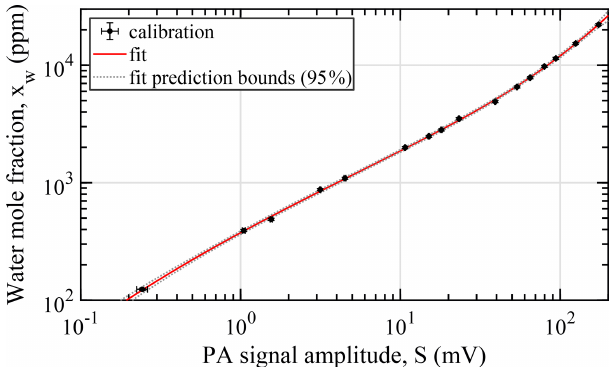
Figure 6. Laboratory calibration data of the PA hygrometer oper- ated at 35 ◦ C, 800hPa, and an integration time of 1s. Calibration humidities were set with the internal humidity generator and in combination with the gas diluter. The fit indicates the best-fit cal- ibration curve with the parameters obtained by the weighted non- linear least-squares method. Error bars of the measurements indi- cate the 95% uncertainty of the humidity generation and standard deviation of the lock-in signal for the y and x axes,